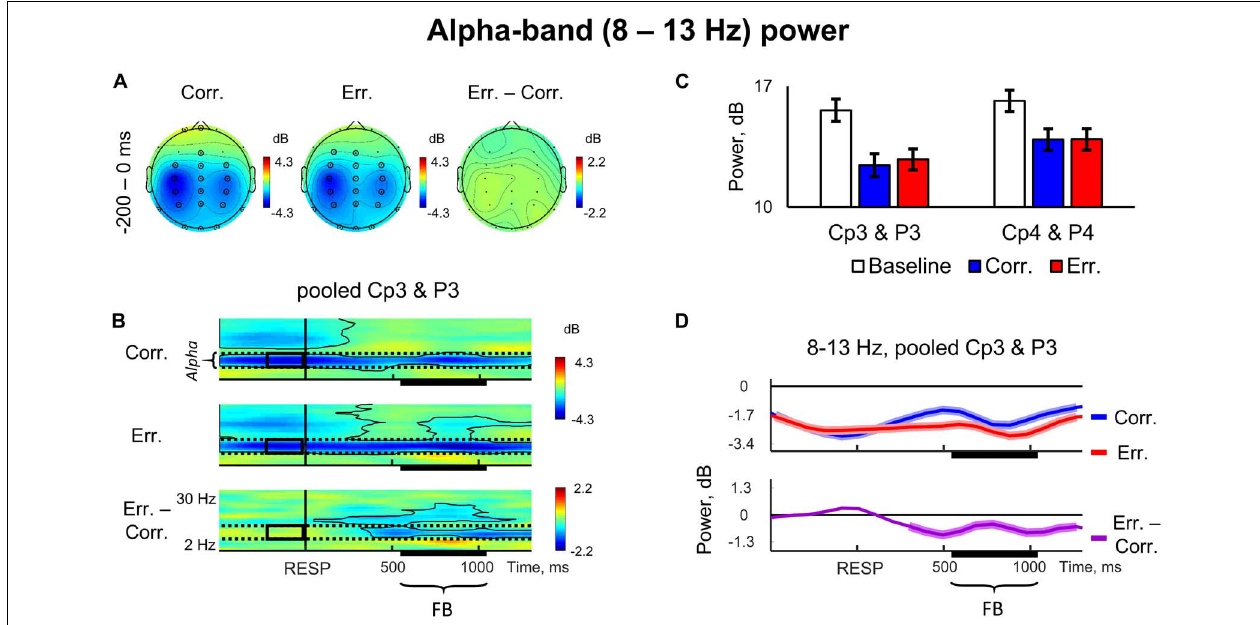
FIGURE 2 | Non-phase locked alpha-band power. (A) Topographical maps of baseline-corrected alpha band activity at − 200 – 0 ms relative to response (left map represents correct responses, middle map – errors, and right map – difference: errors minus correct responses). Significant electrodes highlighted with black circles ( p < 0.05, TFCE, permutation statistics). (B) Time-frequency plots of baseline-corrected averaged event-related spectral perturbation (ERSP) data at pooled Cp3 and P3 electrodes (top plot – correct responses, middle plot – errors, and bottom plots – difference: errors minus correct responses). Black outlines indicate p < 0.05 (TFCE, permutation statistics). Horizontal dashed lines over ERSP plots indicate alpha frequency range (8–13 Hz). Black rectangles represent region of interest: alpha frequency range, − 200 – 0 ms pre-response time-window. Time is shown relative to the behavioral response. (C) Bar plots representing averaged ERSP data at pooled Cp3 and P3, and Cp4 and P4 electrodes, − 200 – 0 ms pre-response time-window. Data are plotted as mean ± standard error of mean. (D) Timecourses of baseline-corrected alpha activity averaged at Cp3 and P3 electrodes. Top subpanel: correct and error trials. Bottom subpanel: difference between erroneous and correct trials. Colored contours superimposed on timecourse lines represent statistical significance ( p < 0.05, TFCE, permutational statistics). Time is shown relative to the behavioral response. “RESP,” behavioral response, “FB,”